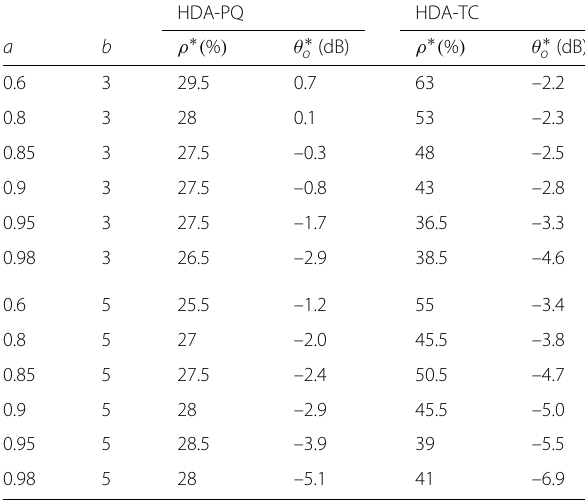
Table 3 The power allocations and outage CSNRs of HDA-PQ and HDA-TC systems shown in Fig. 5 ( right ) HDA-PQ HDA-TC